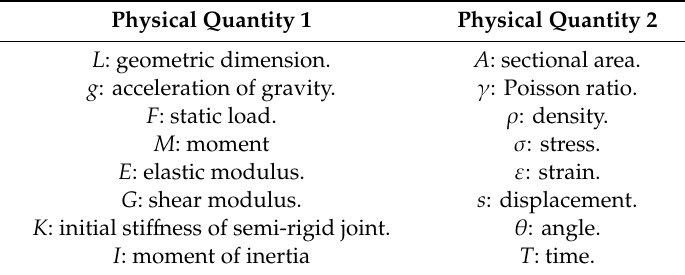
Table 1. Table of the physical